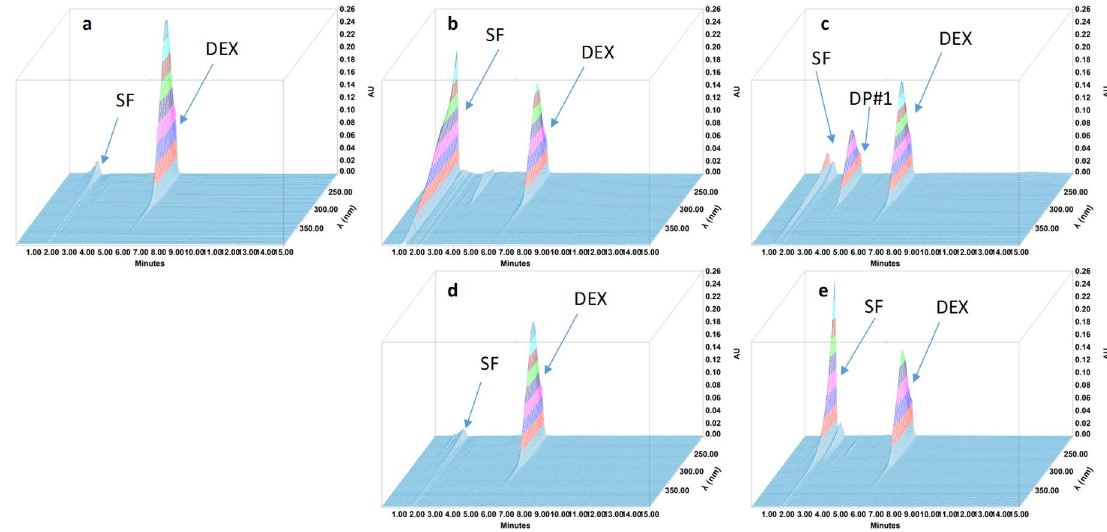
Figure 1. Three-dimensional chromatograms obtained for dexamethasone (DEX) oral suspensions after applying different stress conditions. ( a ) No stress; ( b ) HCl 0.5 M at 80 °C for 30 min; ( c ) NaOH 0.1 M at 80 °C for 10 min; ( d ) H 2 O 2 3% at 80 °C for 4 h; ( e ) 80 °C for 4 h. SF: solvent front; DP: degradation product.